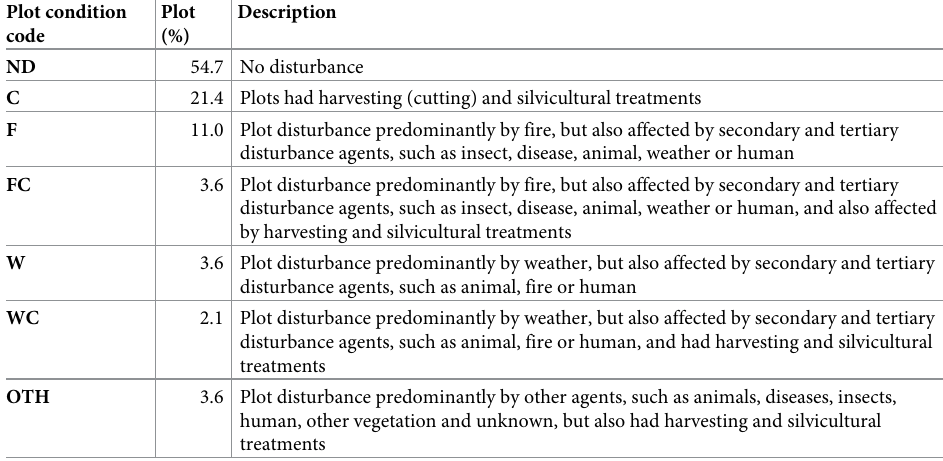
Table 1. Description of plot condition classes based on impact by single or multiple disturbances across the plots (N = 1,432). Plot condition Plot code (%)